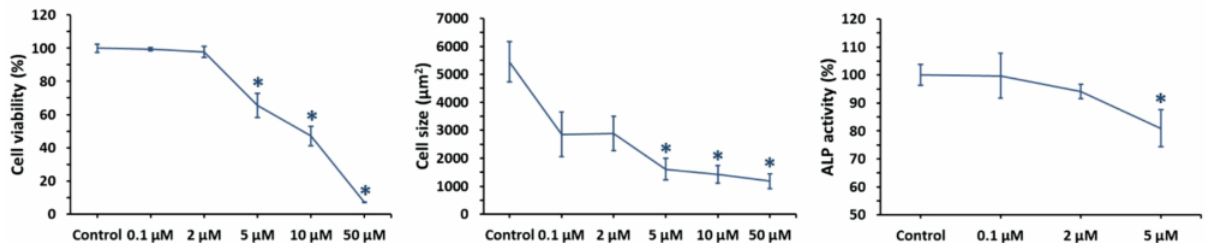
Figure 2. Changes in viability, cell size and ALP activity of human osteoblasts after Cd exposure. * indicates significant ( p < 0.05) di ff erences compared to